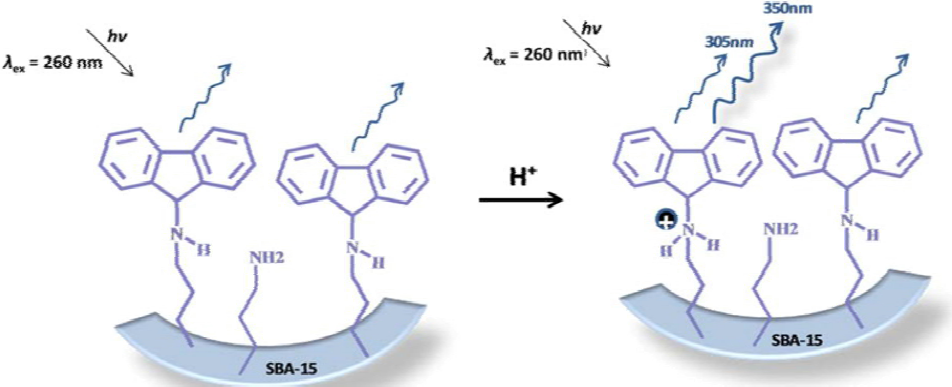
corresponds to 0